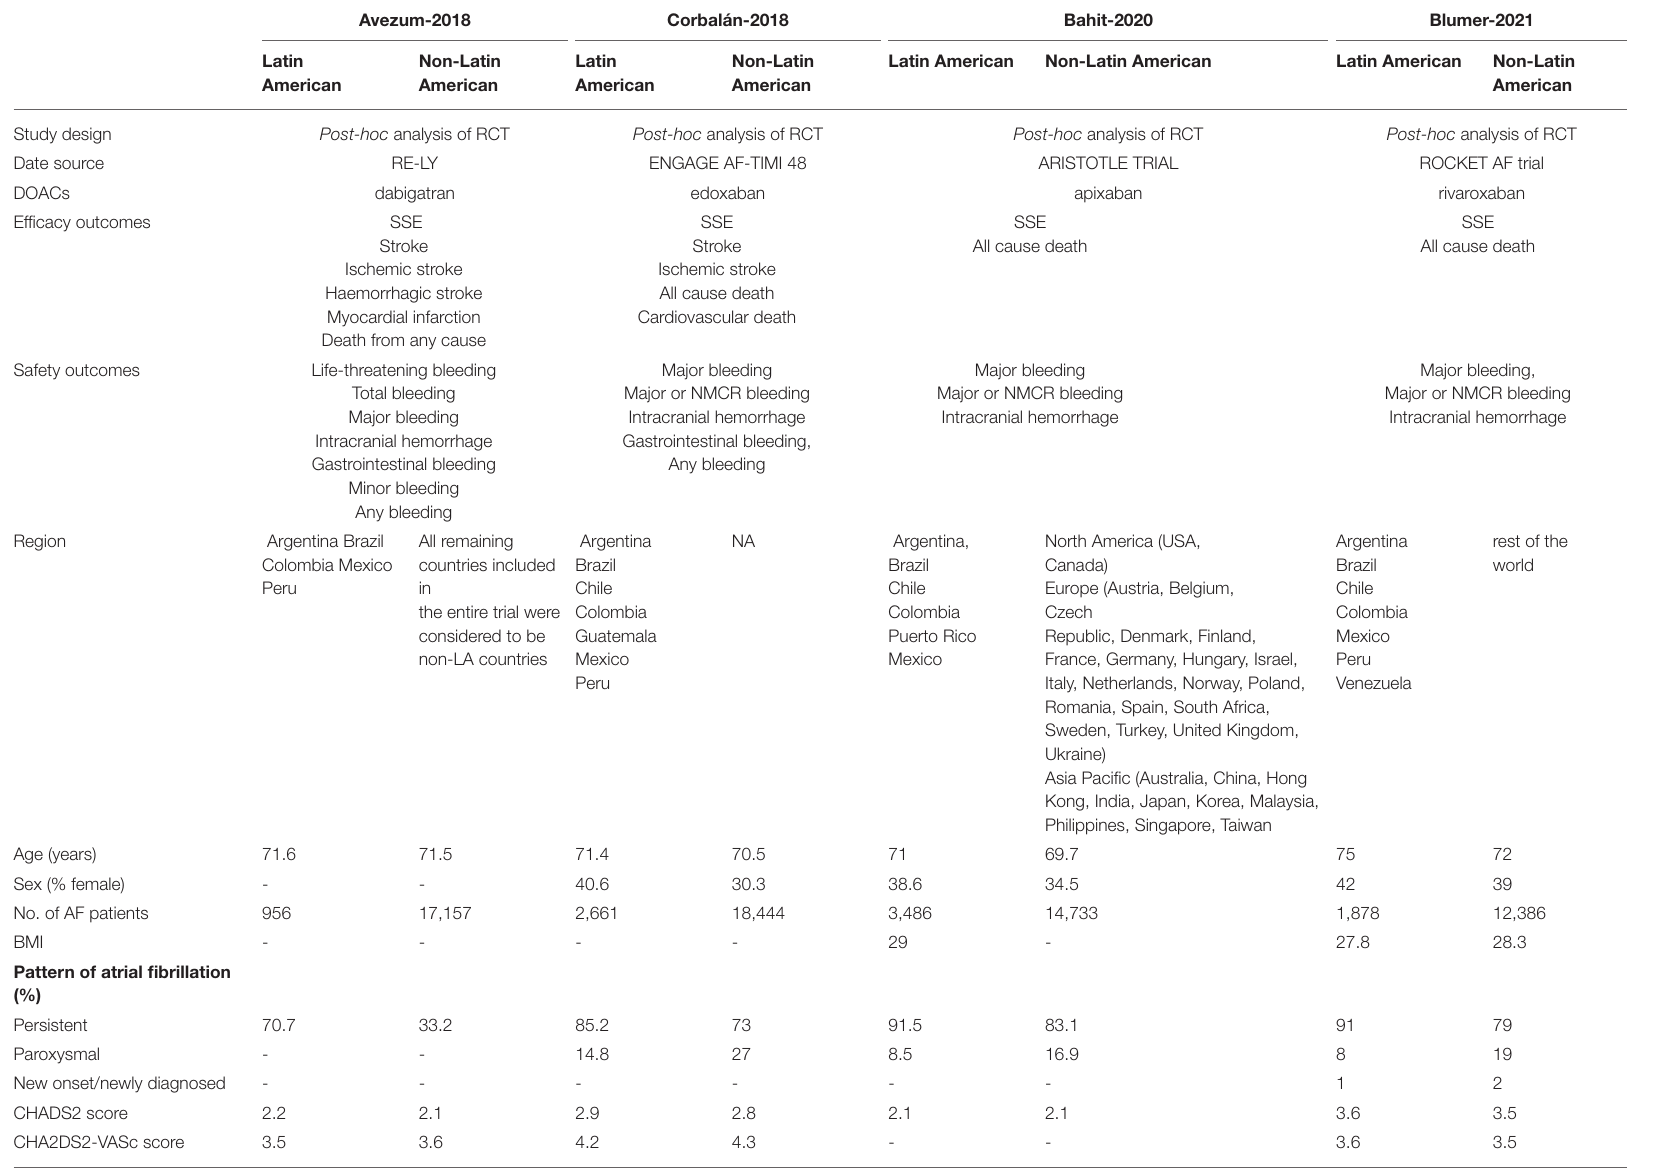
TABLE 1 | Clinical characteristics of the included